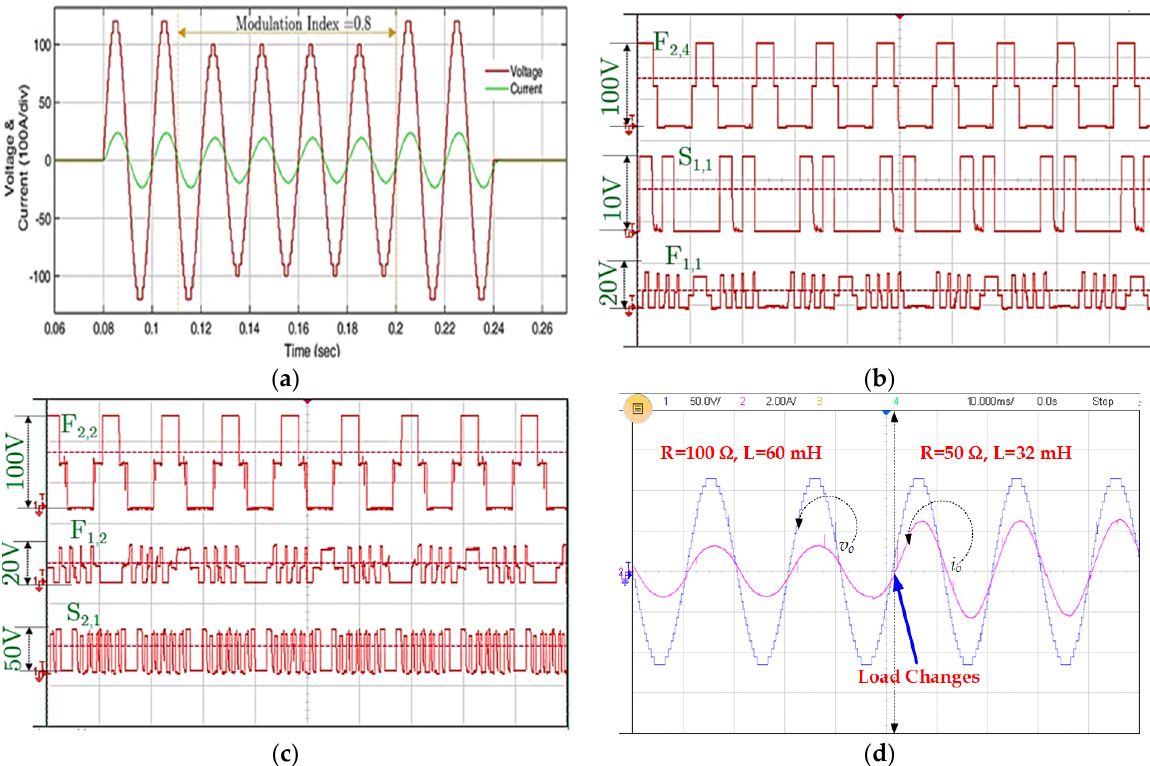
Figure 13. Performance assessment ( a ) Simulation results for various modulation ( b ) Experimental blocking voltage of switches F 2,1 , S 1,1 and F 1,1 ( c ) Experimental blocking voltage of switches F 2,2 , F 1,2 , and S 2,1 , ( d ) Experimental dynamic performance of the proposed 25-Level converter.